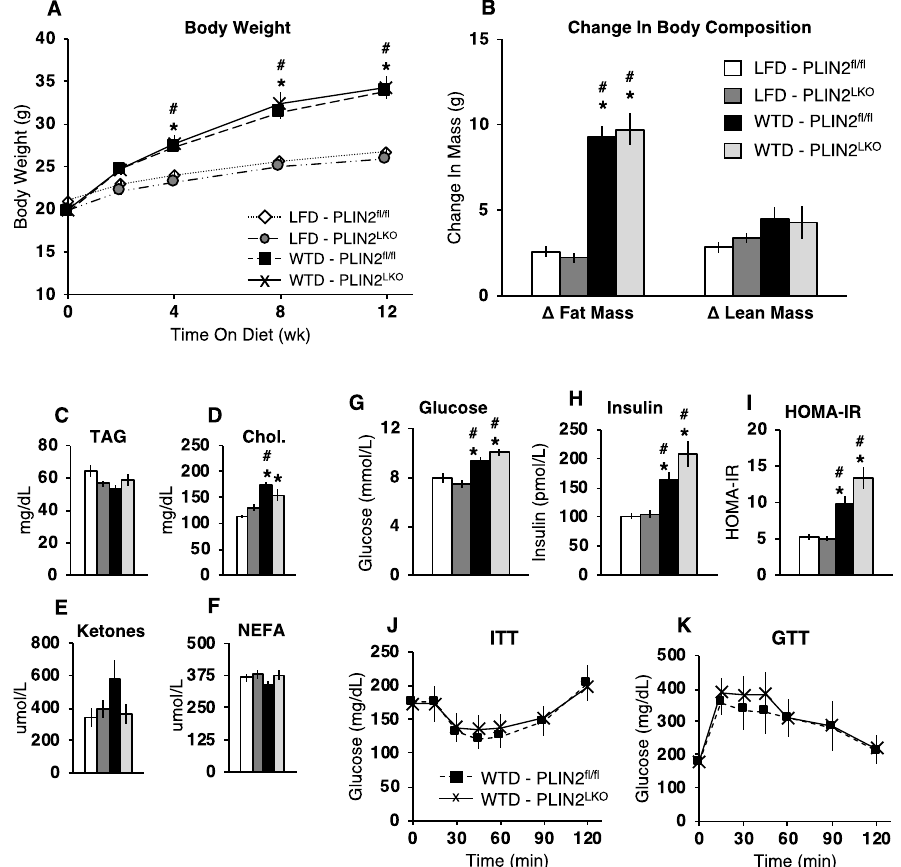
Figure 2. Hepatic PLIN2 loss does not affect body composition, plasma lipids, insulin – glucose homeostasis during LFD or WTD feeding. ( A ) Body weight over time during 12 weeks of LFD or WTD treatment. Animals began diet at 8 weeks of age. ( B ) Change in body composition from baseline, as determined by MRI, following 12 weeks of diet treatment. n = 8 – 13/group. ( C ) Serum triglyceride, ( D ) total cholesterol, ( E ) β -hydroxybutyrate (ketones), and ( F ) non-esterified fatty acids (NEFA) following a 6 h fast in 20-week-old mice treated with LFD or WTD for 12 weeks. n = 8 – 10/group. ( G ) 6 h fasting blood glucose. ( H ) plasma insulin, and ( I ) HOMA-IR in 20-week-old mice following 12 weeks of LFD or WTD. n = 10/group. ( J ) blood glucose response to an intraperitoneal injection of 0.75 IU/kg of insulin (insulin tolerance test, ITT) following a 6 h fast in mice fed LFD or WTD for 16 weeks beginning at 16 weeks of age. n = 8 – 10/group. ( K ) Blood glucose response to an intraperitoneal injection 1.5 mg/g of glucose (30% glucose in PBS, glucose tolerance test, GTT) following a 6 h fast in mice fed LFD or WTD for 18 weeks beginning at age 16 week of age. n = 5/group. Data are presented as the mean ± SEM. For A – C : * p ≤ 0.05 vs. LFD – PLIN2 fl/fl and # p ≤ 0.05 vs. LFD – PLIN2 LKO , as determined by two-way ANOVA and Tukey’s post hoc analysis. For J and K, data were analyzed using students t-test.